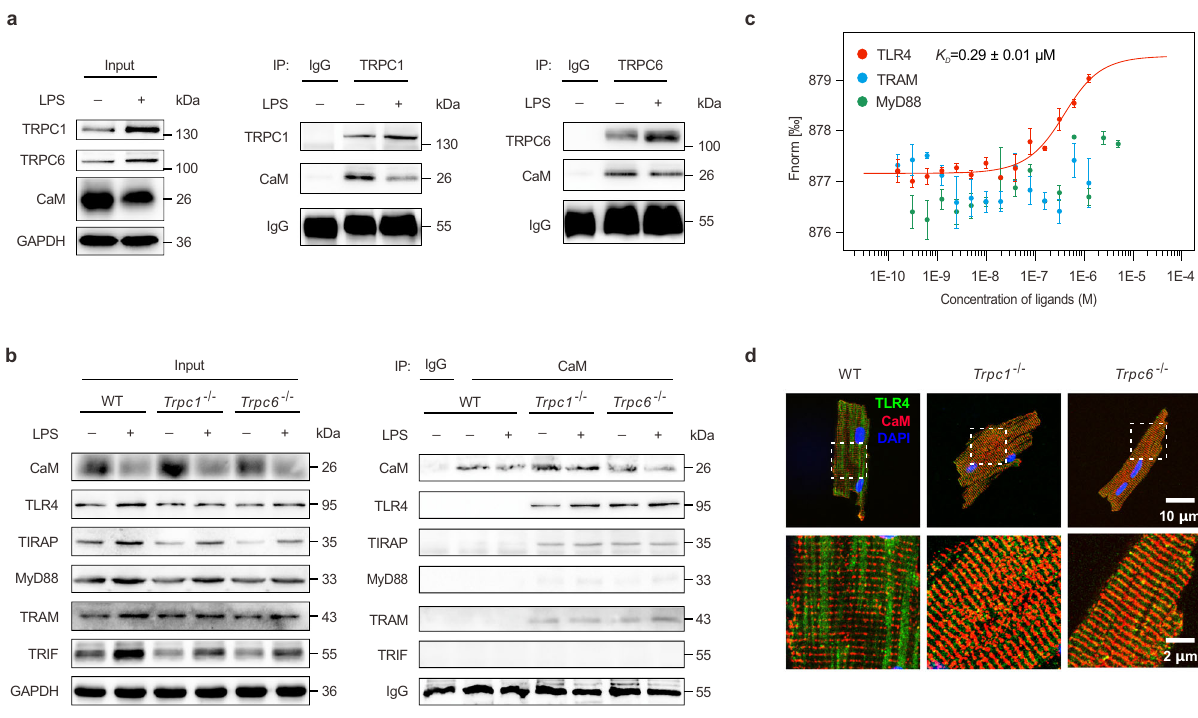
Fig. 4 | CaM interacts with TLR4 in Trpc1 − / − or Trpc6 − / − hearts. a Co- immunoprecipitated (Co-IP) analysis of TRPC1 or TRPC6 interaction with CaM in the hearts of mice 4h after LPS challenge (pooled tissues from 3 male mice per sample, n =2 biological independent experiments). b Co-IP analysis of CaM inter- actionwithTLR4anditsadaptorproteinsin theheartsof WT, Trpc1 − / − ,and Trpc6 − / − mice 4h after LPS challenge (pooled tissues from 3 male mice per sample, n =2